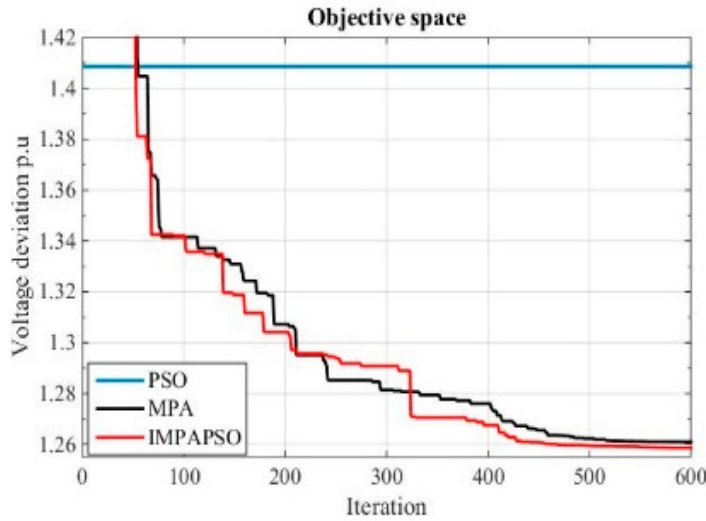
Figure 12. Convergence of PSO and IMPAPSO in the second case of the IEEE 118-bus system.